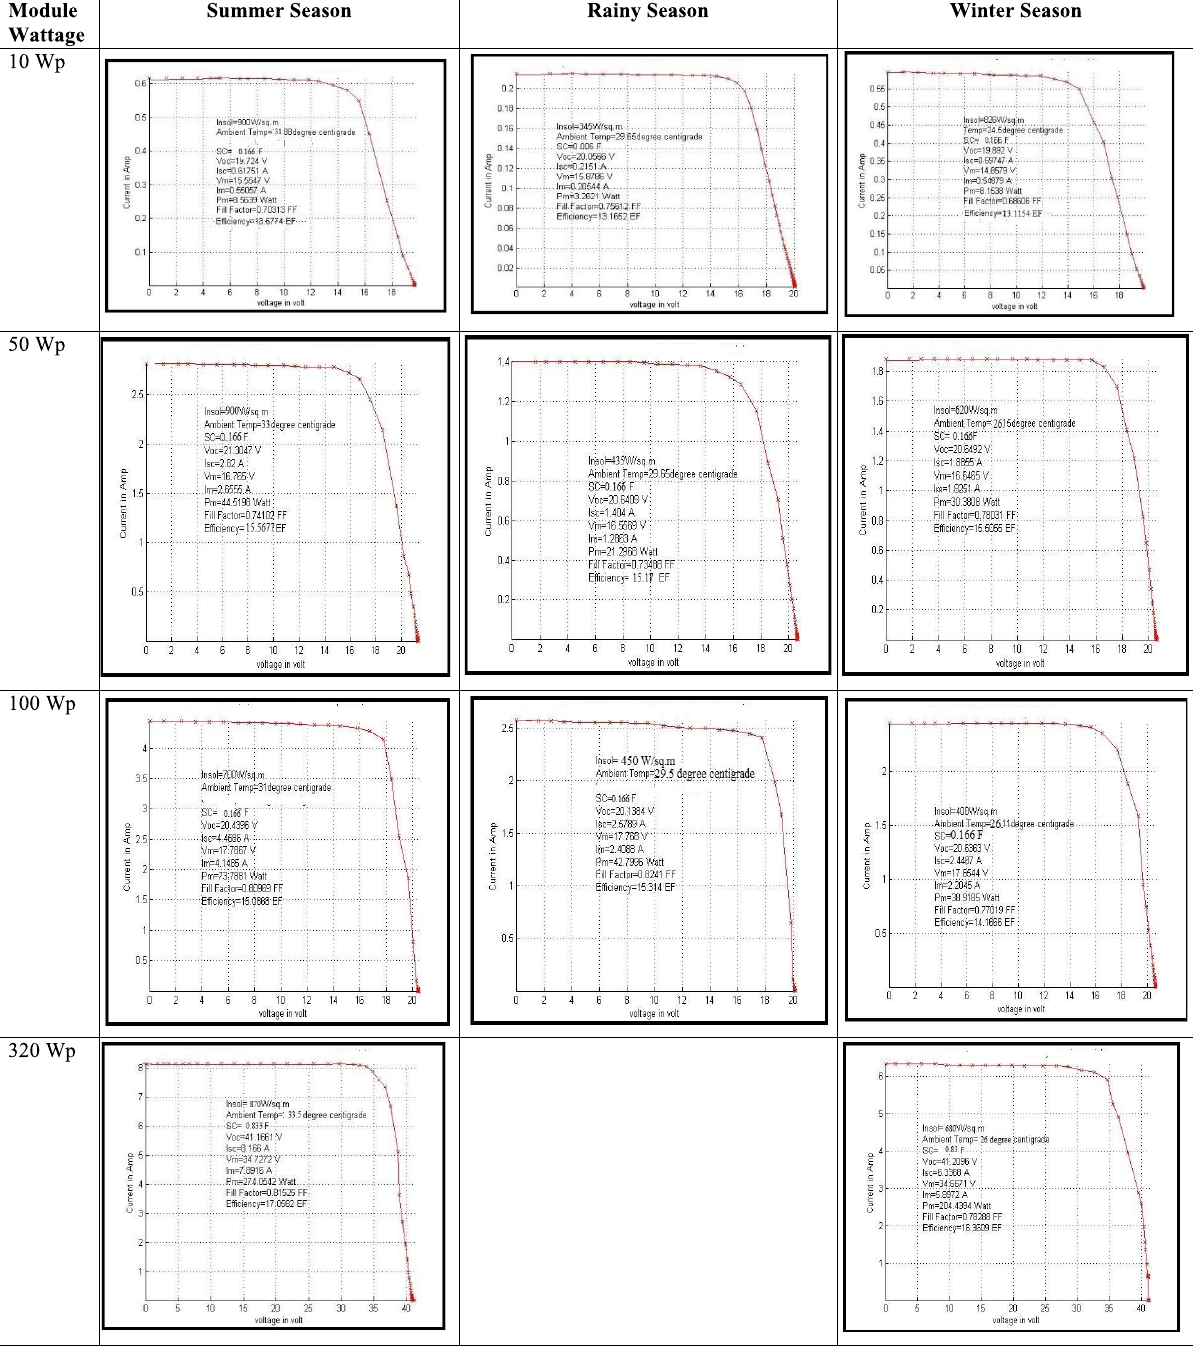
Fig. 8. V – I characteristics of different wattages poly-Si PV modules across three different